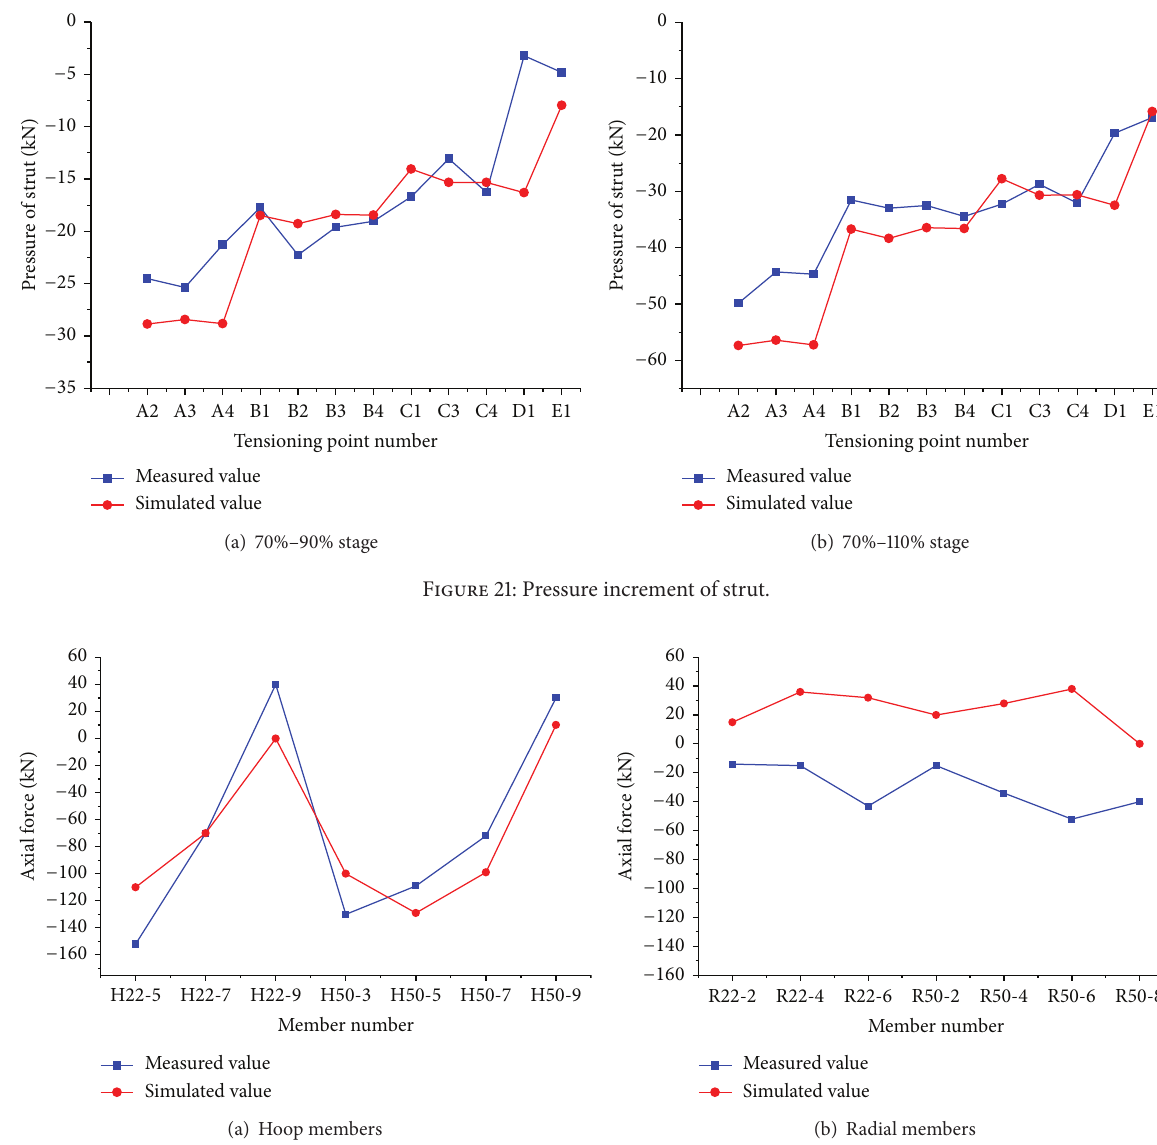
Figure 22: Force increment of the members in the 70%–90%